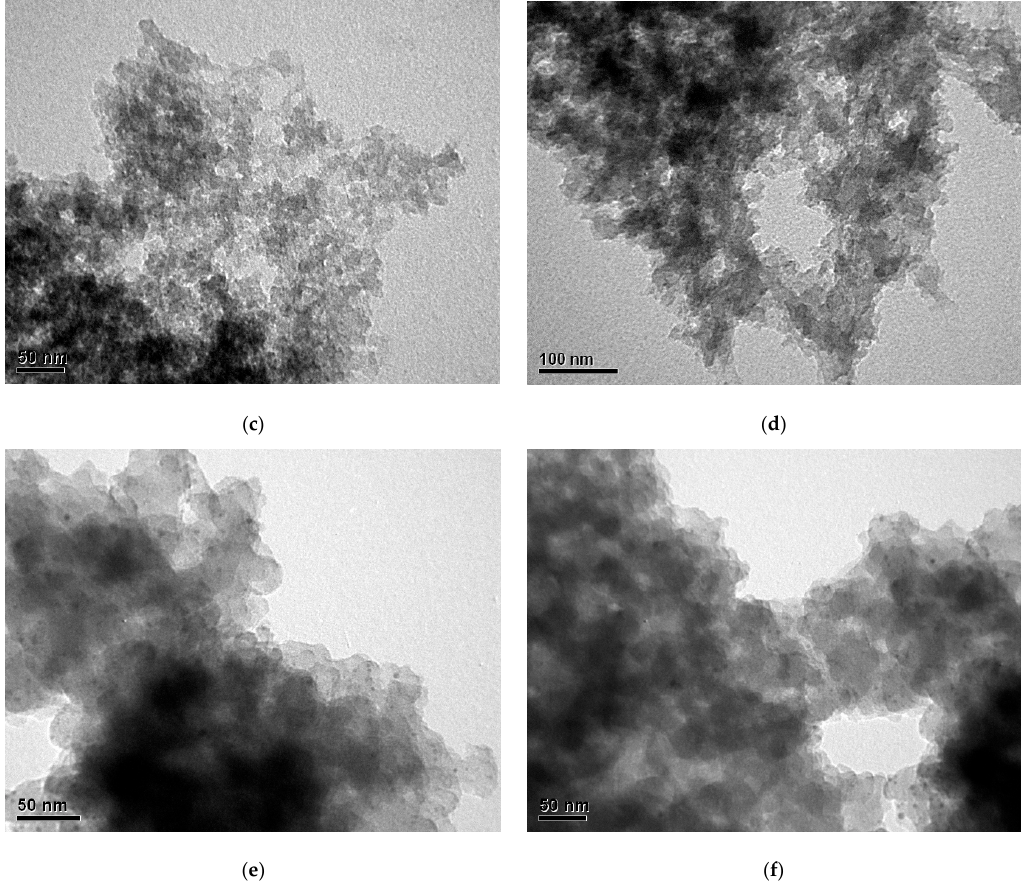
Figure 8. TEM micrographs for the used Pd-based catalysts. ( a ) Pd(CH 3 CO 2 ) 2 ), ( b ) Pd-SALOPHEN, ( c ) PdAS(1)-MA, ( d ) PdAS(2)-MA, ( e ) PdAS(5)-MA and ( f ) PdAS(10)-MA.